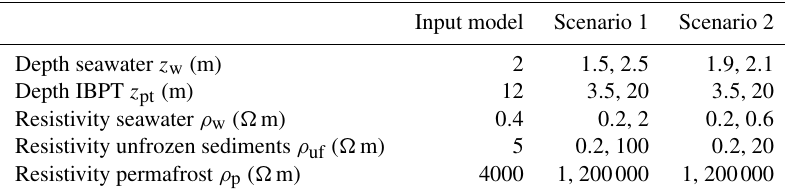
Figure 8. Summary statistics of the residuals for the Drew Point data set corresponding to all models δ F0 and for the three clustered families δ F1 , δ F2 , and δ F3 . (a–d) Median and (e–h) interquartile range calculated in a pixel-wise fashion. (i–l) Histograms illustrating the overall distributions of different statistical measures including RMSLE ( δ ) , IQR ( δ ) , and q 90 ( δ ) . Table 3. Parameters of the 1D synthetic model of Drew Point and for two scenarios indicating the lower and upper bound parameter